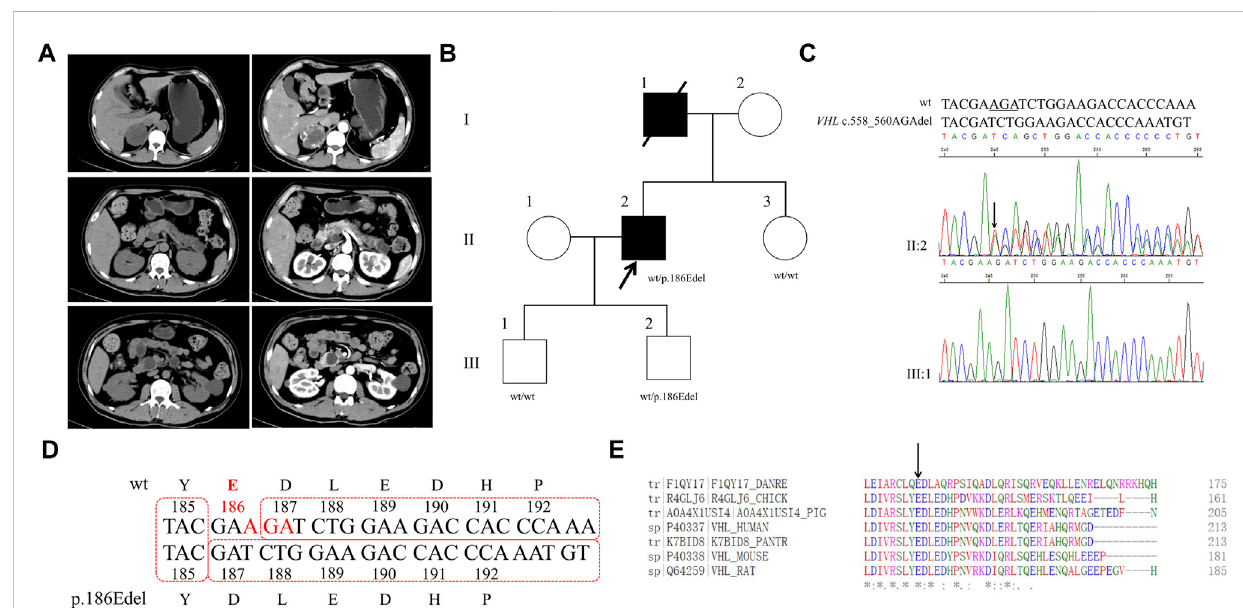
FIGURE 2 Clinical and genetic characteristics of Proband 2. (A) CT (left) and contrast-enhanced CT scan (right) imaging in a 33-year-old male patient with PPGL showing right adrenal occupancy (upper), pancreatic polycysts (middle), and kidney carcinoma (bottom). (B) Pedigree of the Proband 2 family with PPGL. Squares and circles indicate males and females, respectively; Roman numerals indicate generations; and Arabicnumerals indicate individual family members.Eachmember ’ s VHL genotypeareshownbelowthesquaresandcircles.Wt,wildtype.E,glutamicacid.Del,deletion. (C) DNAsequencing data of an unaffected male (III:1) and the Proband 2 (II:2) with the heterozygous variant of VHL c.558_560AGAdel. Wt, wild type. Del, deletion. (D) The deletion of glutamicacid incodon 186 of VHL resulting from VHL c.558_560AGAdel. Wt,wild type. Y,tyrosine; E, glutamicacid; D, asparticacid; L,lysine; H, histidine; P, proline; del, deletion. (E) Multiple protein sequence alignment of seven species for VHL p.186E (arrow). An asterisk (*) indicates positions thatare100%conservedinthealignment,andacolon(:)indicatesconservationbetweengroupsofstronglysimilarproperties,whilstaperiod(.)indicates conservation between groups of weakly similar properties. The residues in the alignment are coloured to indicate their physicochemical properties. Red indicates small and hydrophobic amino acids, blue indicates acidic residues, magenta indicates basic and green denotes hydroxyl/sulfhydryl/amine